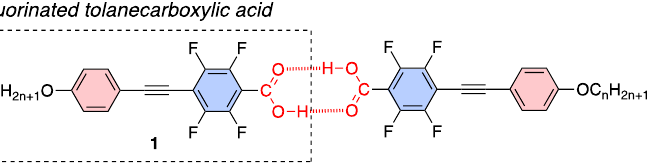
Figure 2. Chemical structure of the fluorinated tolanecarboxylic acid 1 used in this study and plausible aggregated structure in crystalline and LC phases through hydrogen bond.